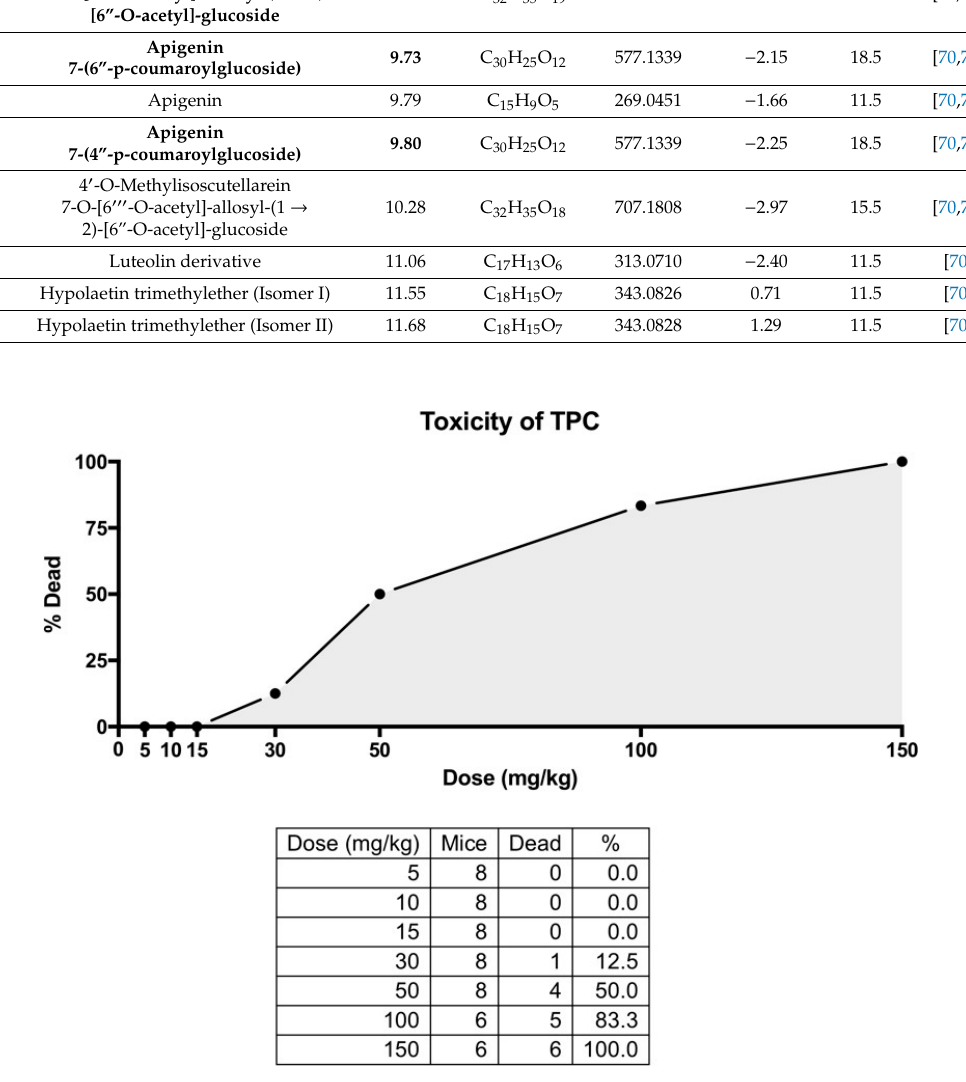
Figure A1. Analysis of Extract Toxicity.